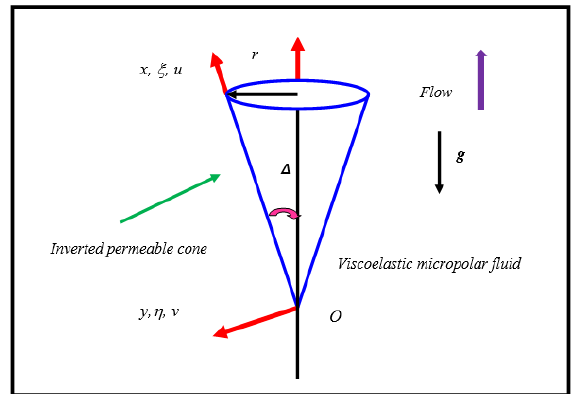
Fig. 1: Physical model and coordinate system